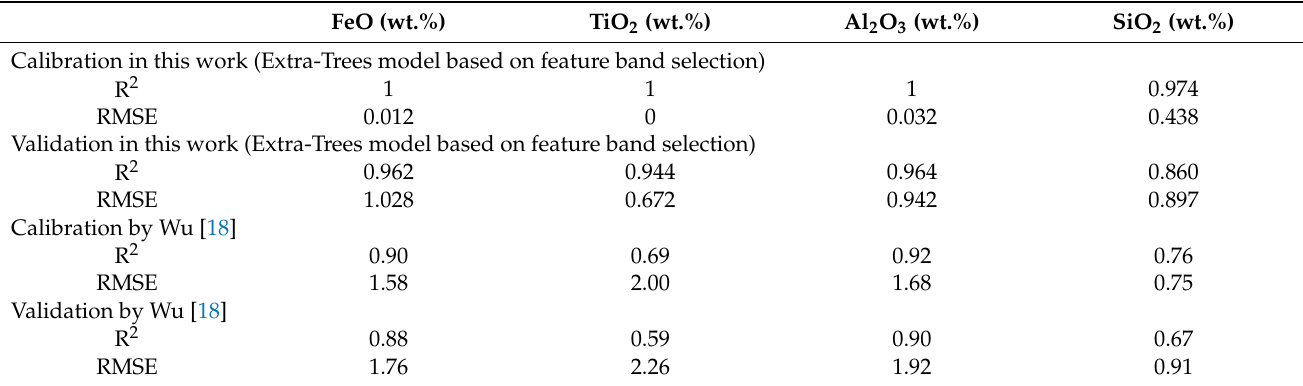
Table 4. Comparison of the accuracy of the four chemical abundance tests with the results of Wu [18]. FeO (wt.%) TiO 2 (wt.%) Al 2 O 3 (wt.%) SiO 2